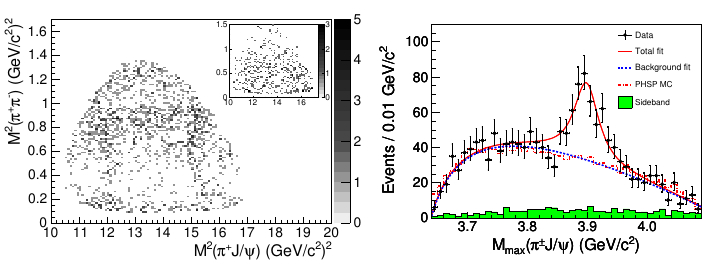
Figure 1. Dalitz plot for selected e + e − → π + π − J /ψ events in the J /ψ signal region (left panel), and unbinned maximum likelihood fit to the distribution of the M max ( π J /ψ ) (right panel).